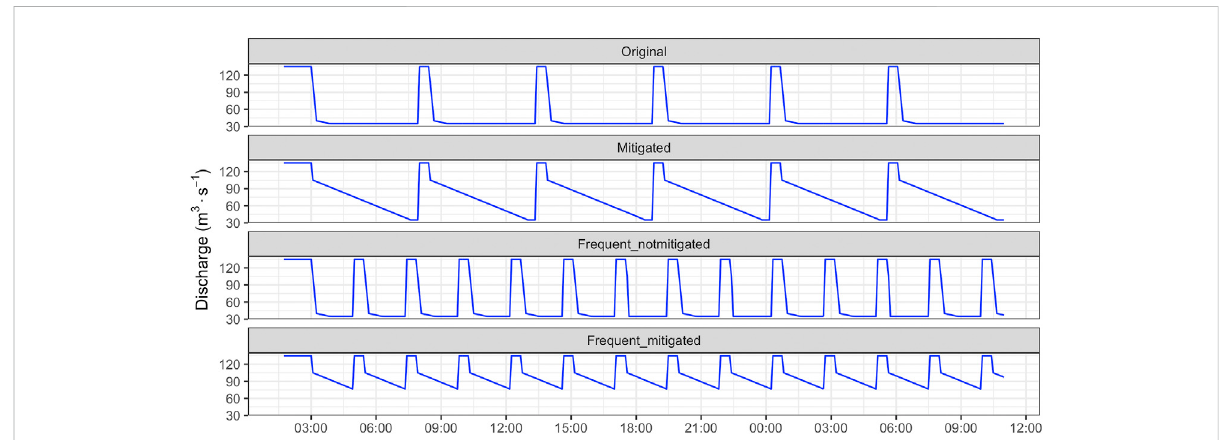
FIGURE 9 Asuccessionofsynthetichydrographswithmultiplestopsperday.Thetwouppergraphsshowthestandardhydrograph(original)andmitigated hydrograph (mitigated). The two lower graphs show a frequent succession of starts and stops without mitigation (frequent_notmitigated) and the frequent start – stop scenario with mitigation (frequent_mitigated).